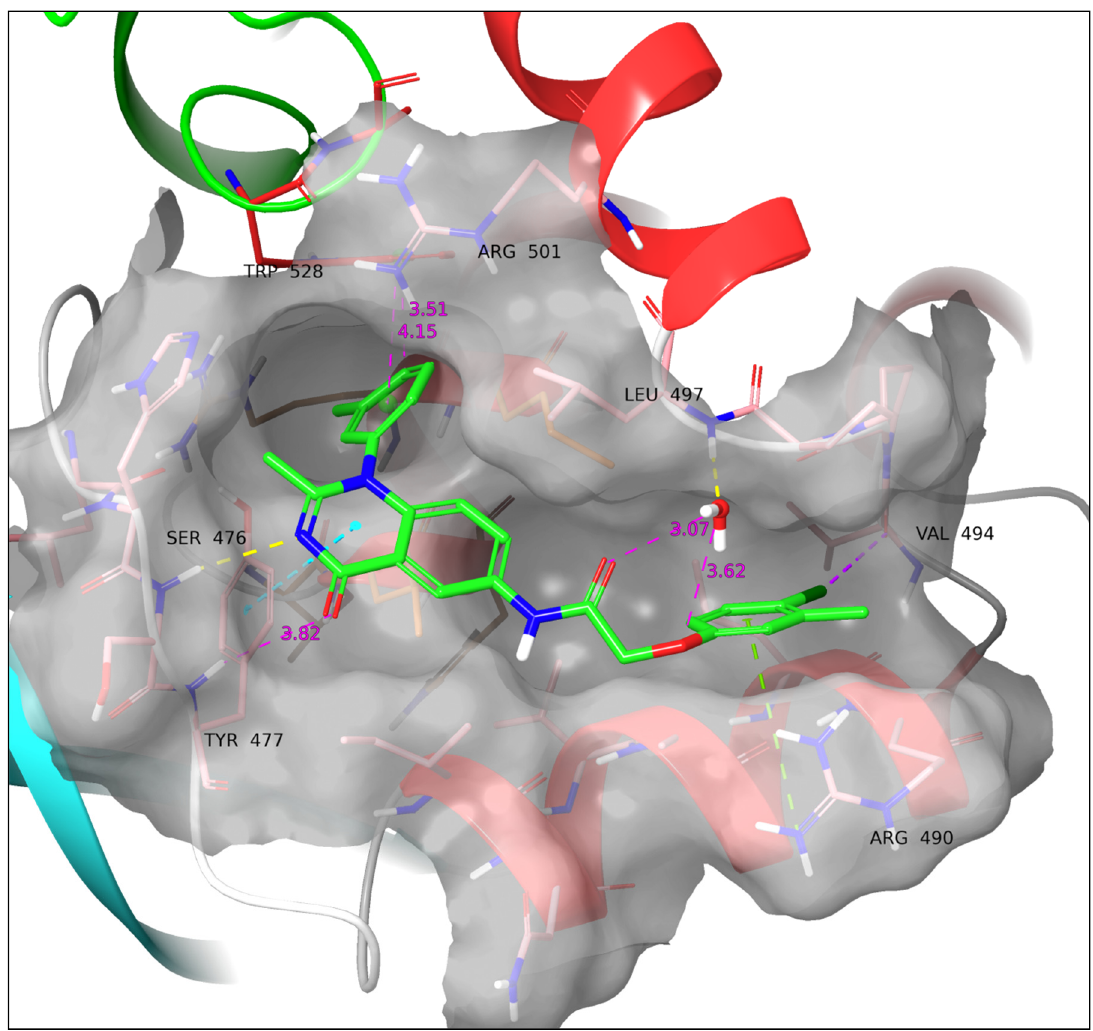
Figure 10. Docking pose of 11f . A hydrogen bond with Ser476, a sandwich π – π stacking with Ty477, a cation– π interaction with Arg490, and a halogen bond with Val494 are formed. Yellow dotted line: Hydrogen bond. Cyan dotted line: π – π interaction. Green dotted line: cation– π interaction. Purple dotted line: Halogen bond. All the above SARs were identified employing the default settings of Maestro. Violet dotted line and number: Atom/ring distance in Å (measured manually).